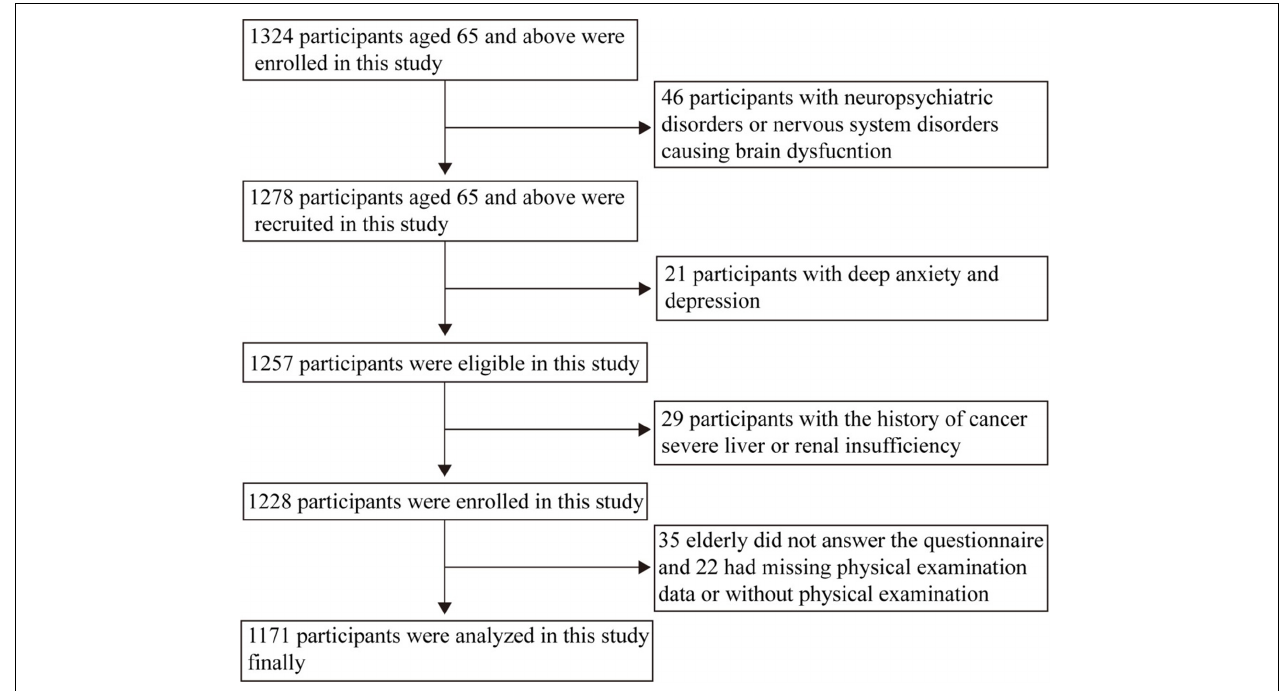
FIGURE 1 | Flow diagram showing the recruitment and exclusive of the